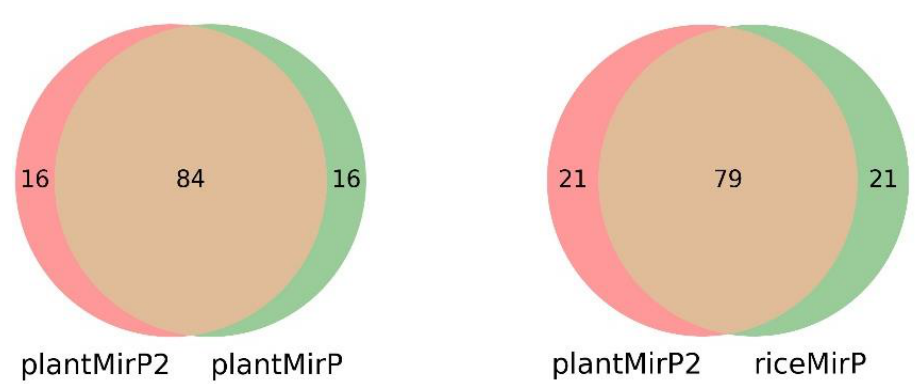
Figure 4. Venn diagram results for the top predictions of plantMirP2, plantMirP and riceMirP. PlantMirP is the first plant pre-miRNA tool with knowledge-based energy features calculated from distance-specific k -mer pair potentials. In plantMirP, knowledge-based